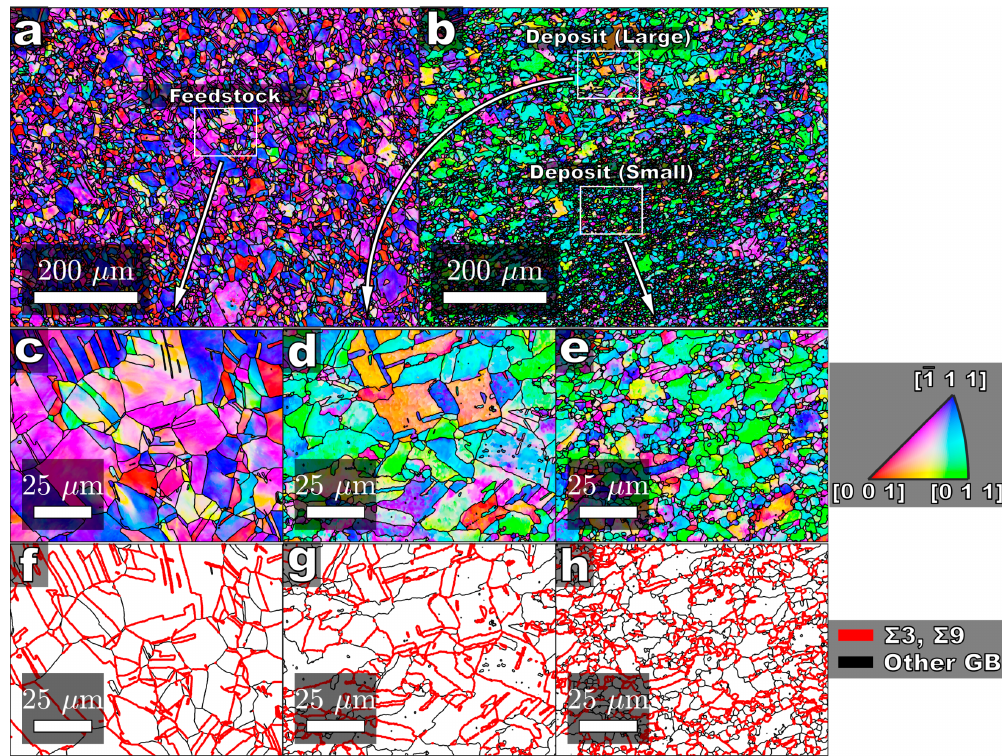
Figure 4. Microstructural evaluation of the feedstock and the deposit center by electron back-scatter diffraction. The two inverse pole figures at the top are survey maps collected at 150 × for the feedstock ( a ) and the deposit ( b ). Remaining plots ( c – h ) are microstructural maps at 1000 × , drawn from locations identified in ( a , b ); these plots are organized in columns for each location in ( a , b ). The rows correspond to inverse pole figure maps ( c – e ) and twin boundary maps ( f – h ). The color scheme for each row is located to the right.